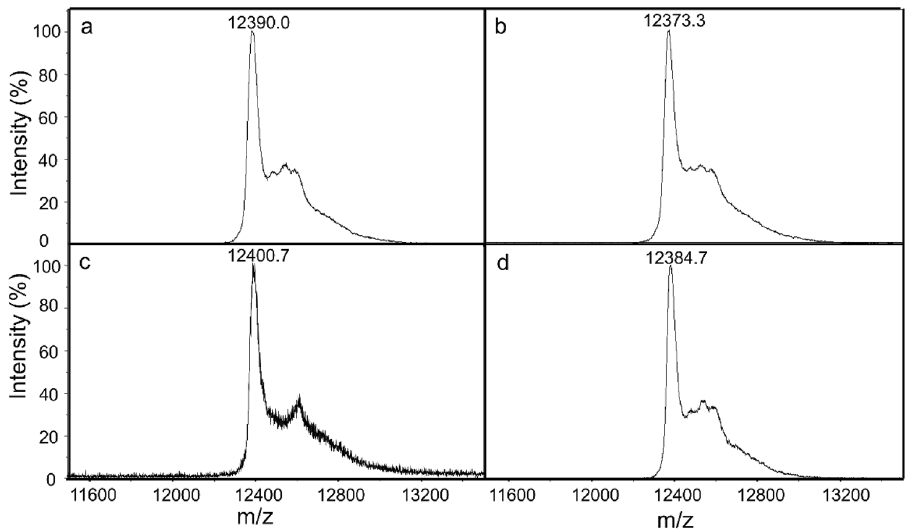
Figure 1. Mass spectra of pristine ferric ( a ), pristine ferrous ( b ), CL-bound ferric ( c ), and CL-bound ferrous ( d ) cyt c after 50-min deuteration. The CL-bound cyt c was prepared by incubating cyt c with a CL/DPPC liposomal solution at 30 °C for 10 min (see “Experimental” section for